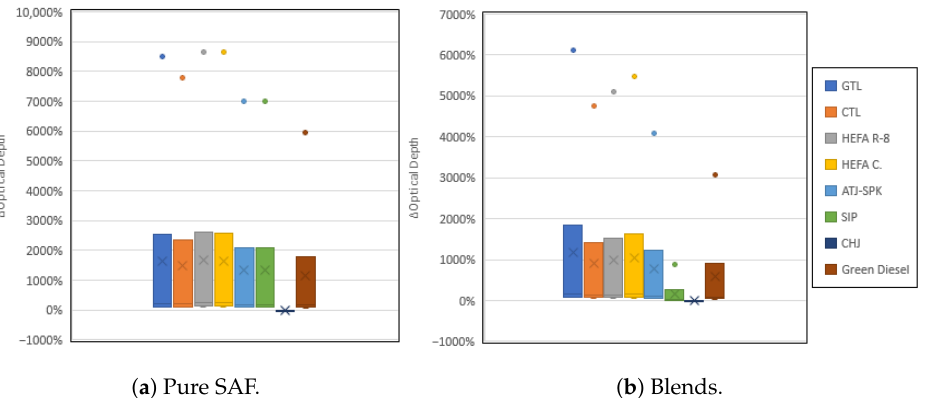
Figure 16. RDs in peak optical depths for ambient relative humidities at formation in the range of 40% to